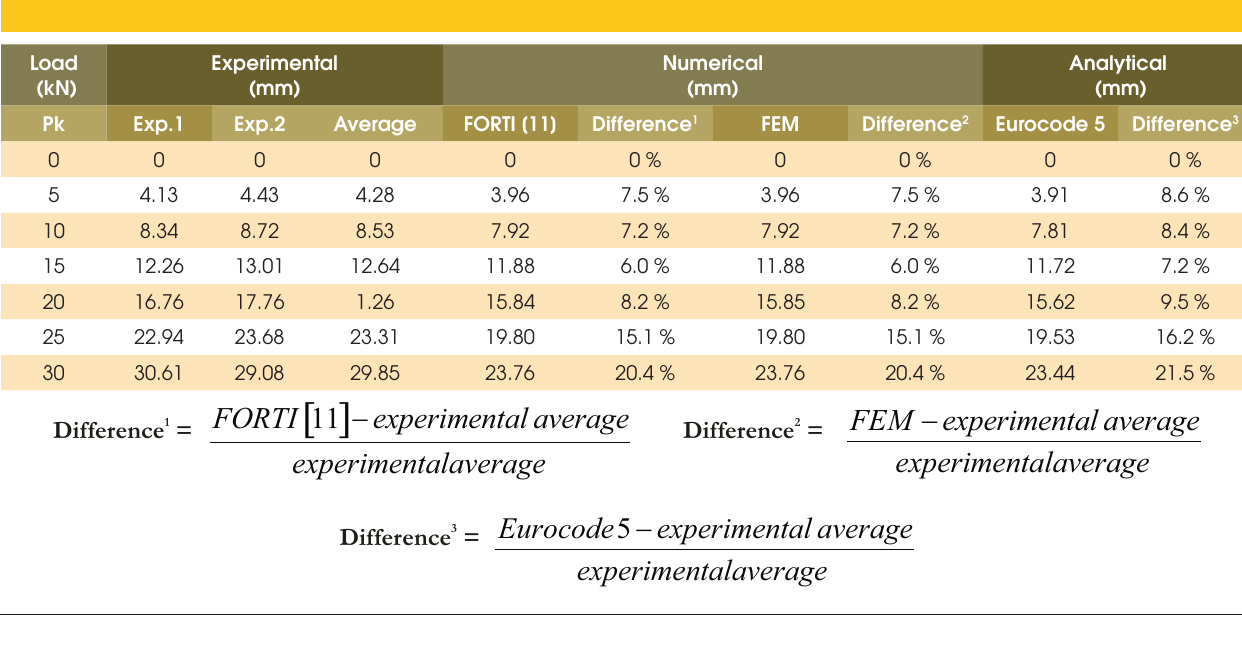
Table 2 – Results of vertical displacements at L/2 of the composite